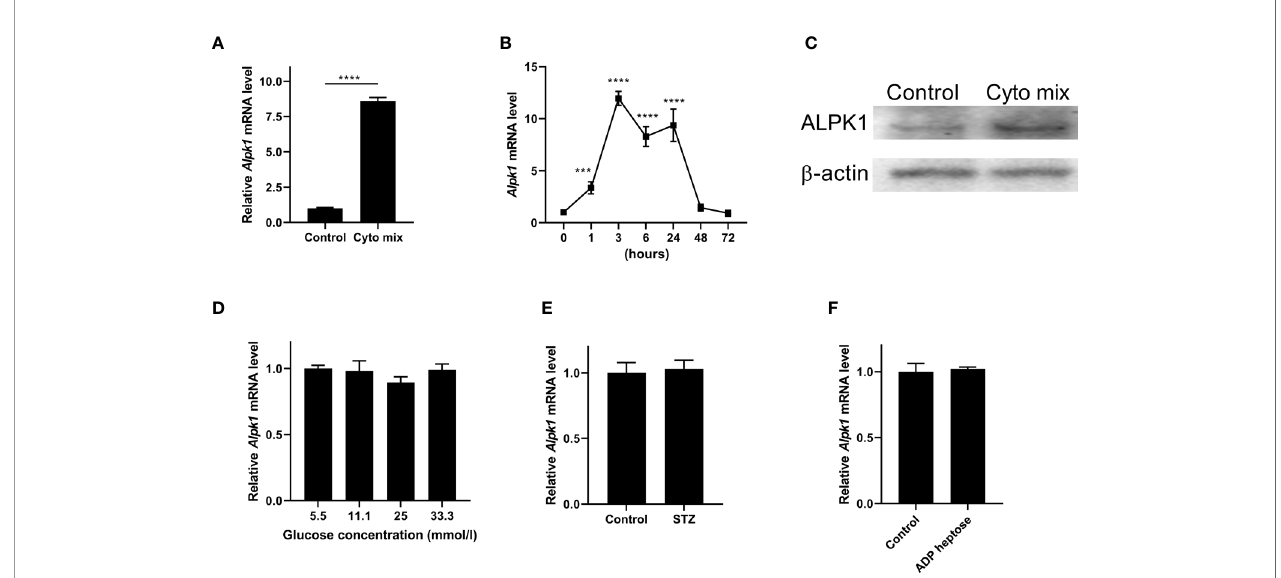
FIGURE 1 | Alpk1 expression was induced by pro-in fl ammatory cytokines in MIN6 cells. (A) MIN6 cells were untreated or treated with a mix of pro-in fl ammatory cytokines (cyto mix; 10 ng/ml IL-1 b , 10 ng/ml TNF- a , and 10 ng/ml IFN- g ) for 24 hours. Alpk1 mRNA level was measured by qRT-PCR. (B) Time-course expression of Alpk1 exposed to cyto mix. (C) MIN6 cells were untreated or treated with cyto mix for 24 hours. Alpk1 protein level was measured by western blotting. (D) MIN6 cells were treated with various concentrations of glucose for 24 hours. (E) MIN6 cells were treated with vehicle or 10 mM STZ for 24 hours. (F) MIN6 cells were treated with vehicle or 32 µM ADP heptose for 24 hours. Alpk1 mRNA level was measured by qRT-PCR. Data show mean ± SD and are representative of 3 independent experiments. The data shown in (A, E, F) are were analyzed with unpaired Student ’ s t-test, and data in (B, D) were analyzed with ANOVA followed by